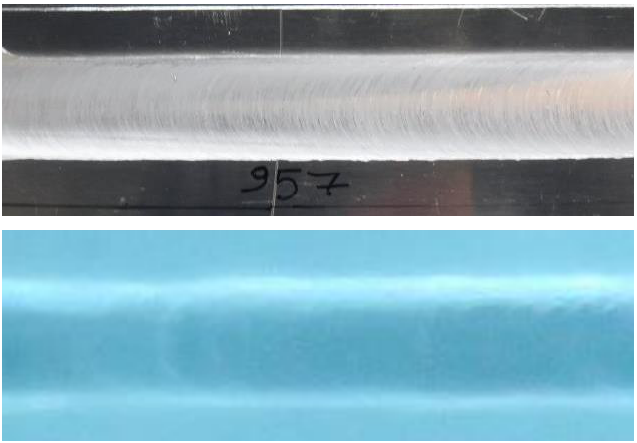
Figure 9. X-ray test for sample 957.